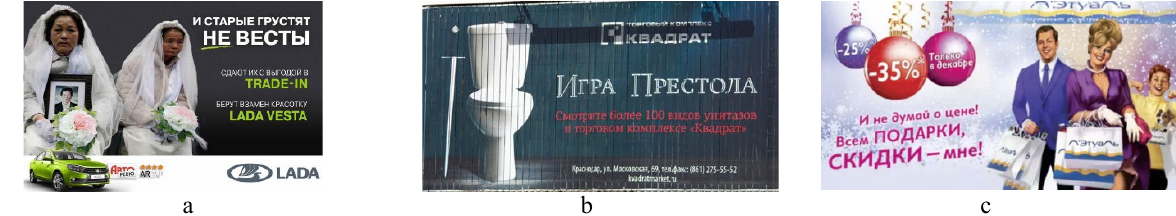
Fig. 10 – Examples of advertising with expressive